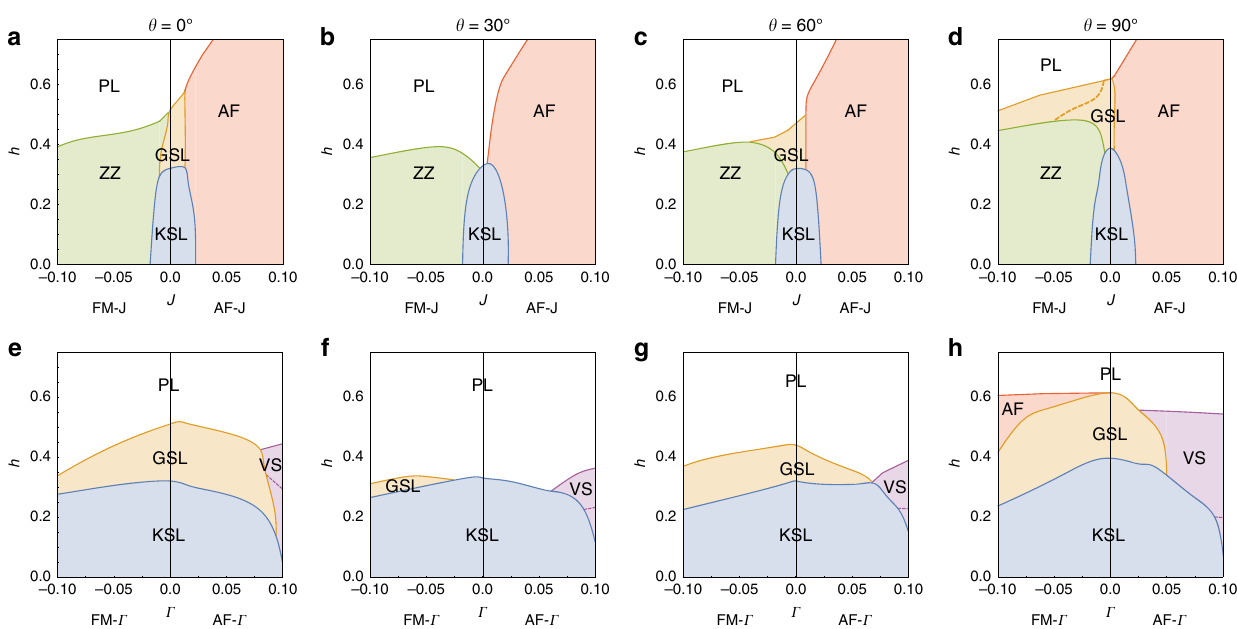
Fig. 6 Phase diagrams beyond the pure Kitaev model. Effects of a – d an additional Heisenberg and e – h an additional off-diagonal Γ exchange on the KSL and GSL in tilted magnetic fi elds. The Kitaev interaction is parameterized by α and the perturbing coupling by (1 − α )/2, with α = 1 corresponding to the pure Kitaev model and α = 0.8 to the edges of the phase diagram, J = ± 0.1, Γ = ± 0.1. In the presence of additional Heisenberg interactions both spin liquid phases eventually give way to either zig-zag (ZZ) or antiferromagnetic (AF) ordering. The inclusion of the additional off-diagonal Γ -exchange affects the stability of the spin liquid phases in a lesser way, with AF or vortex state (VS) order arising only for large coupling strengths. Note that in all phase diagrams the GSL appears to piggypack on the KSL phase, indicating that it is in fact of a descendant of the KSL